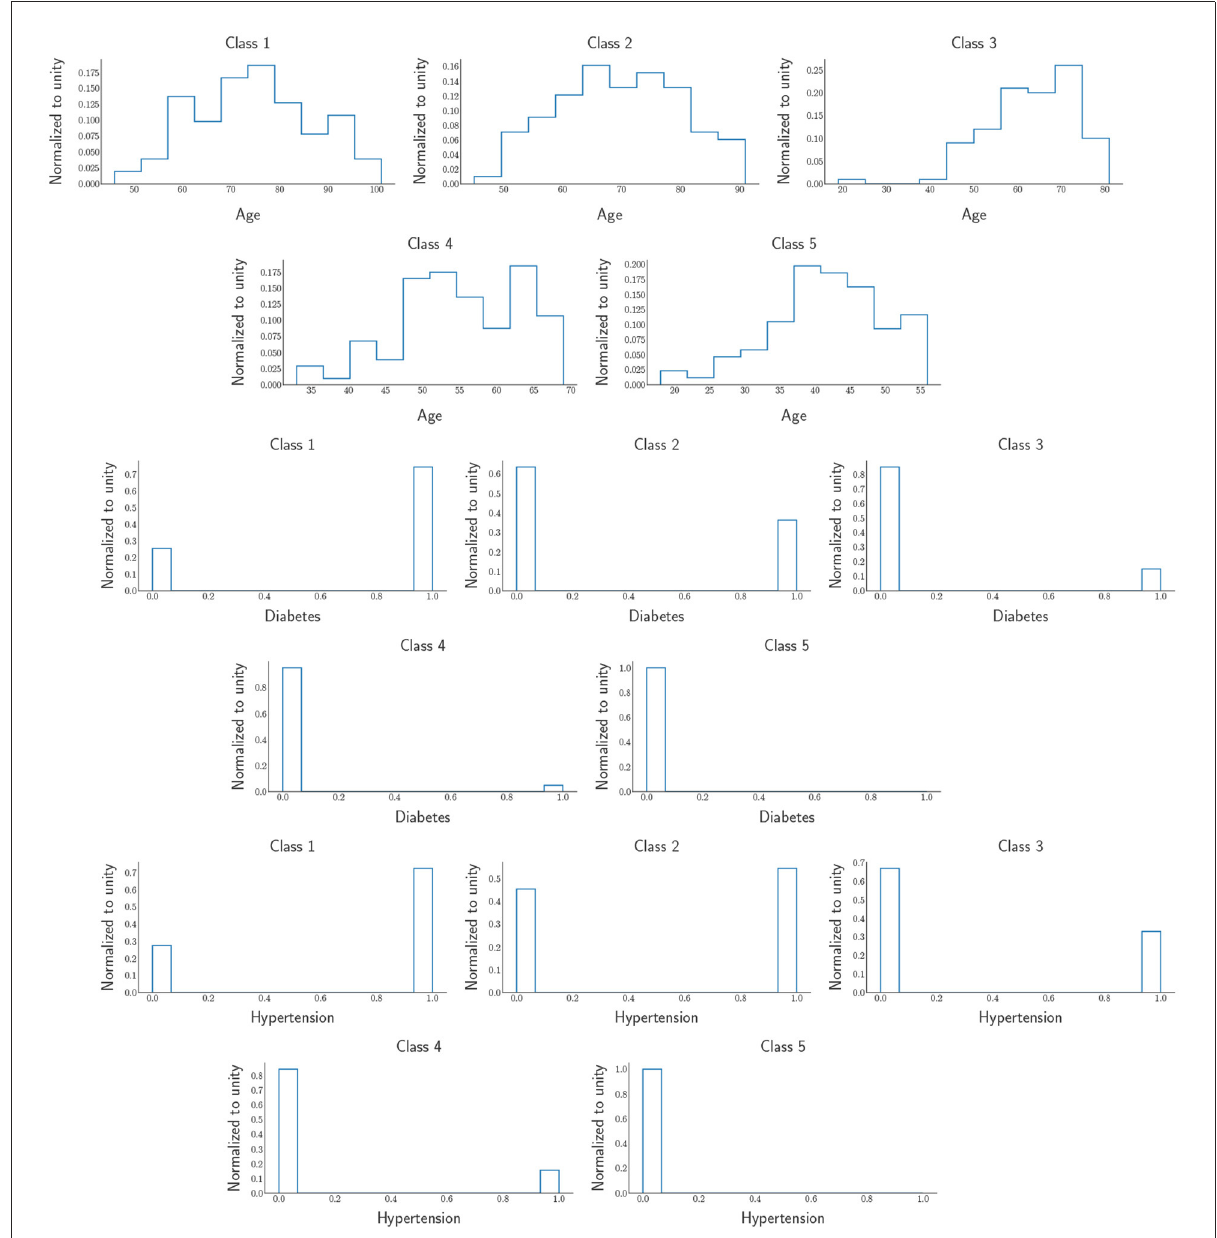
FIGURE13 Five classes were obtained from DNN output distributions. The distributions include Age, Diabetes, and Hypertension. The first (last) row is the most (least) severe target group which is Class 1 (Class